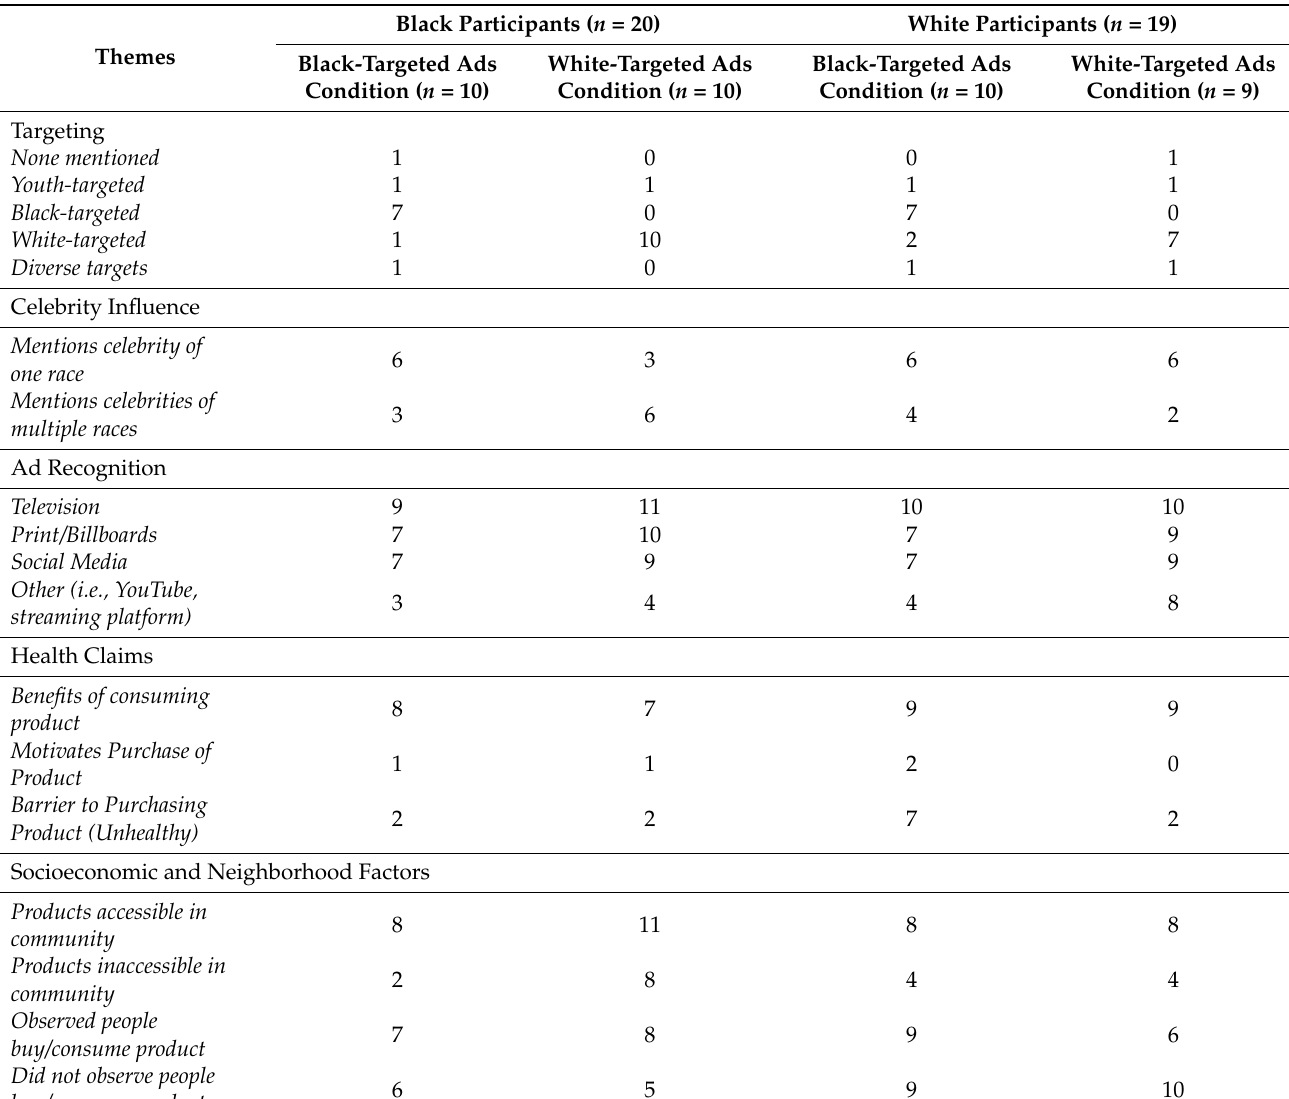
Table 4. Frequency of key themes in participants’